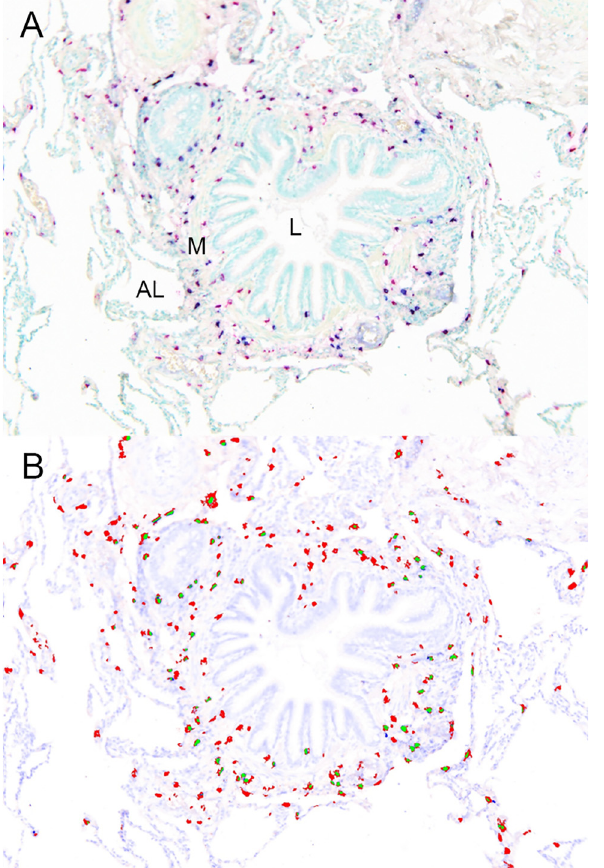
Fig 1. Example of an immunohistochemical staining and its corresponding spectral image. A Small airway containing different subtypes of mast cells: MC T (tryptase only) are in pink (Liquid Permanent Red, DAKO), MC TC are double positive for pink and blue (Vector blue, Vector Labs). Section is counterstained with methylene green. AL, alveolar lumen; L, airway lumen; M, smooth muscle. B Co-localization using spectral imaging technique: red dots representing MC T , green dots representing MC TC . Original magnification: